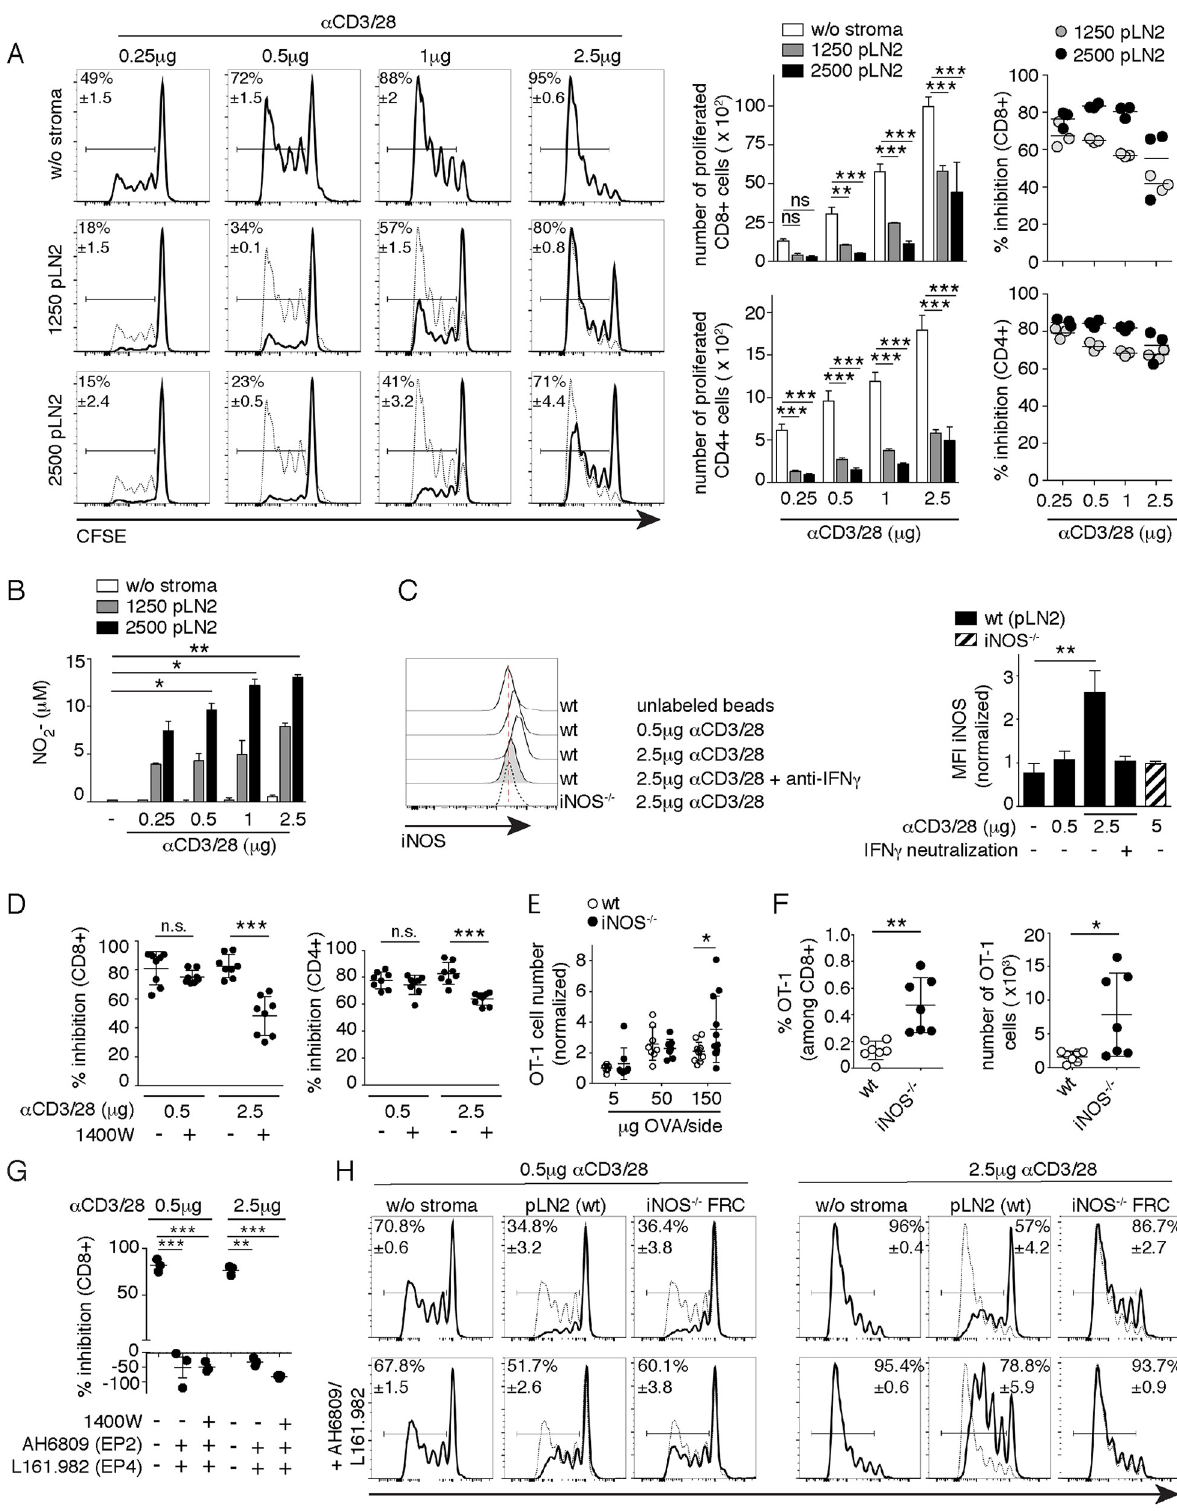
Fig 3. NO released by FRCs dampens mainly strong T-cell responses, while COX2-dependent prostanoids dampen both weak and strong T- cell responses. Flow cytometric analysis of CFSE dilution in CD8+ and CD4+ T cells that were activated with beads coated with indicated